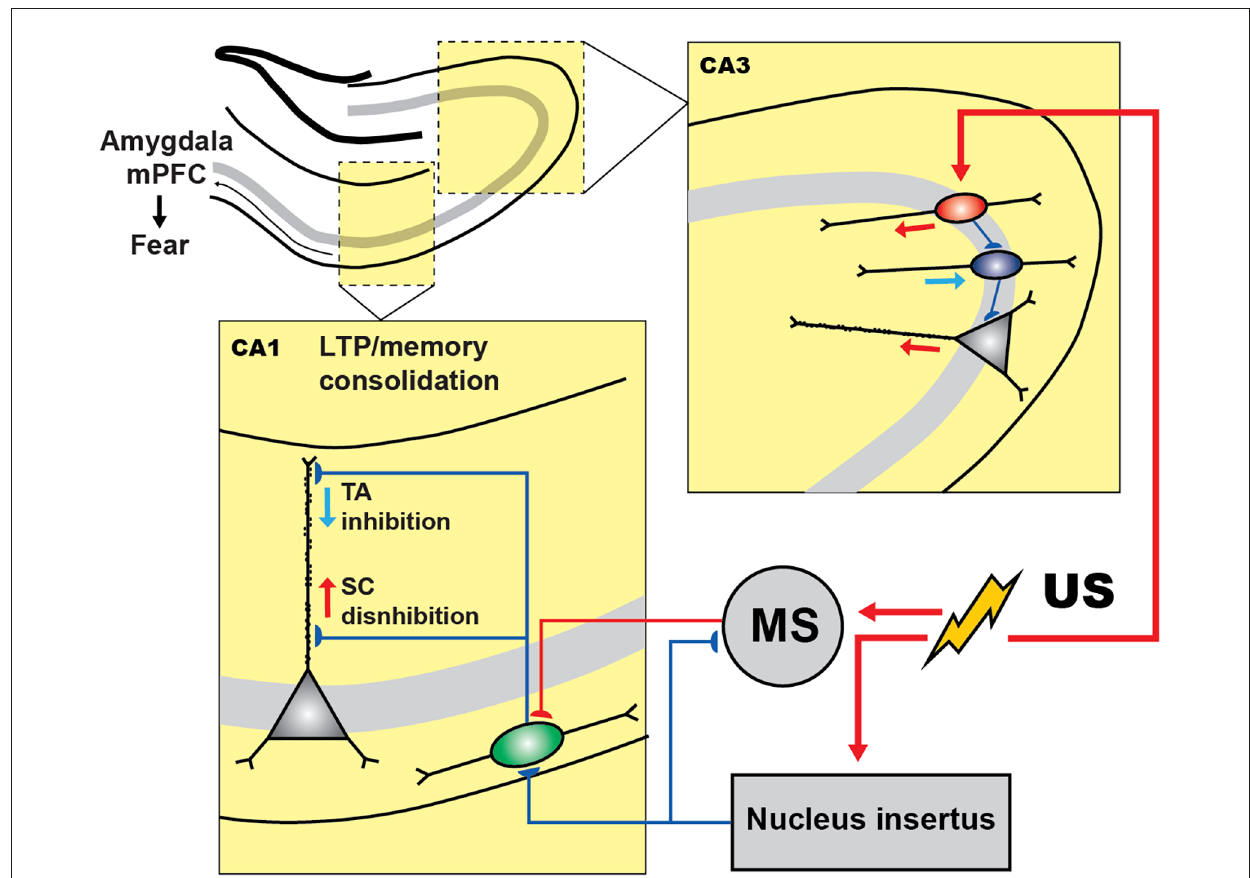
FIGURE2 Inhibitory and disinhibitory circuit motifs in the hippocampus during fear encoding. In CA3 region of hippocampus shock presentation induces the PC disinhibition via inhibiting the PV+ cells (blue) by the activation of VIP+ population (red), which can control the fear expression. In CA1, during CFC, shock presentation resulted in the activation of the medial septum (MS) whose excitatory inputs to SOM+ cells (green) cause the PCs dendritic inhibition. However, the activity of SOM+ and MS are under the control of GABAergic nucleus incertus (NI) input that is also activated by the shock and regulates the fear